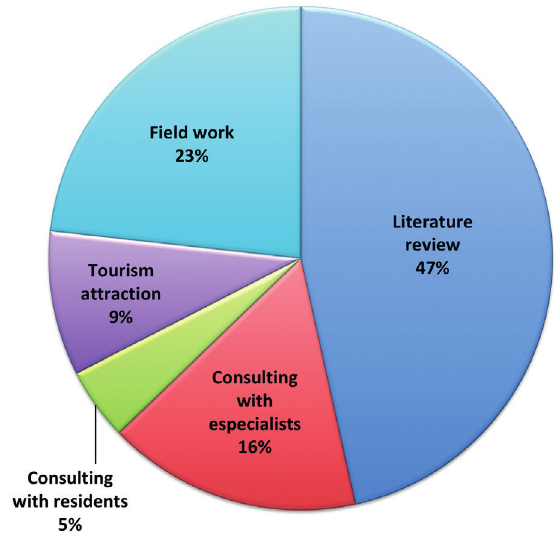
Figure 9 - Sources used to select the